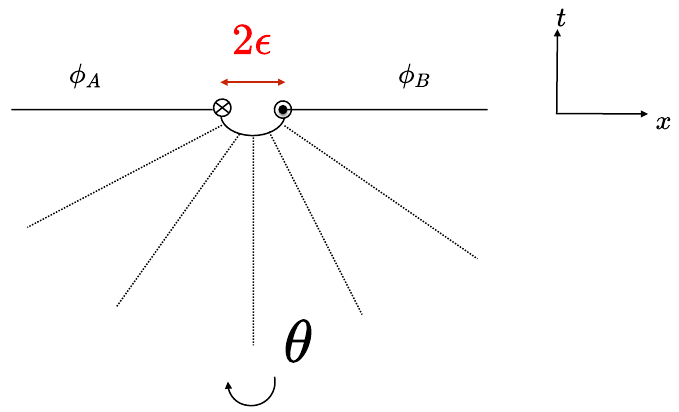
Figure 1 . The wavefunctional prepared by the Euclidean path integral can be sliced in angular time (cid:18) , provided we remove an (cid:15) neighborhood of the entangling surface. When viewed as the initial and (cid:12)nal time slices in (cid:18) , region A and B are assigned opposite orientations relative to the ambient space A [ B . Thus they support the Hilbert space of a chiral and anti-chiral edge CFT, which transforms non-trivially under the boundary gauge group. In addition to parity, switching from t to (cid:18) also involves a time reversal because they have opposite orientations on region B at the t = 0 time slice. Sliced in angular time, the Euclidean path integral prepares a Thermo(cid:12)eld double state in which the left right entanglement of these CFT’s leads to singlet state under a diagonal action of the boundary gauge group on @A and @B